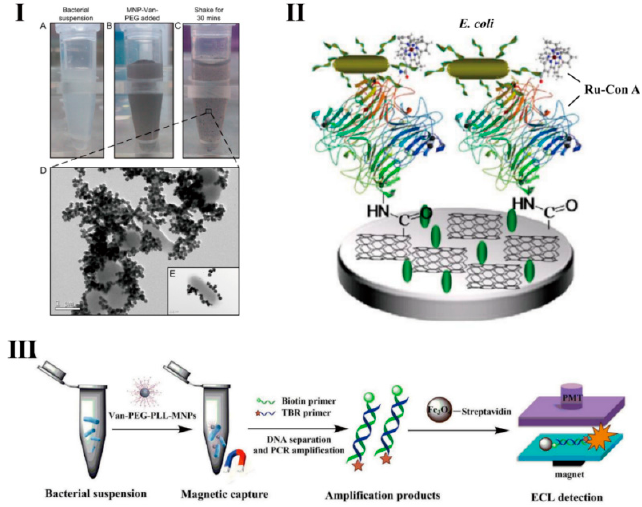
Figure 2. ( I ) Electron microscopic results of vancomycin-modified magnetic beads captured by L. monocytogenes . Reproduced with permission from [72], published by American Chemical